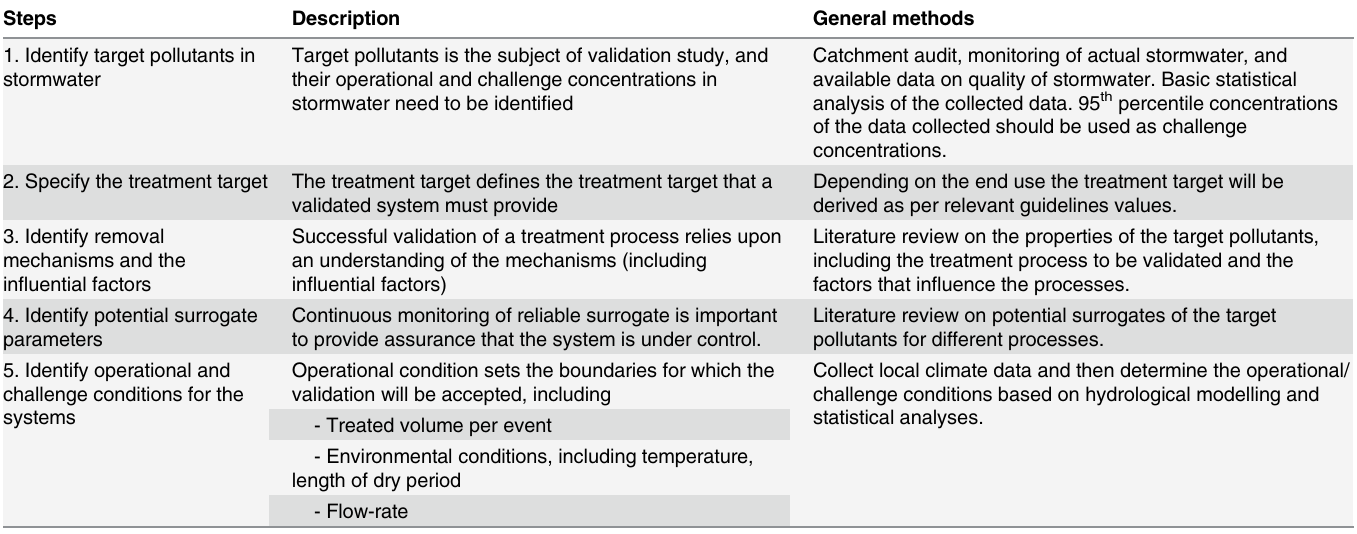
Table 2. Roadmap for Stage 1: